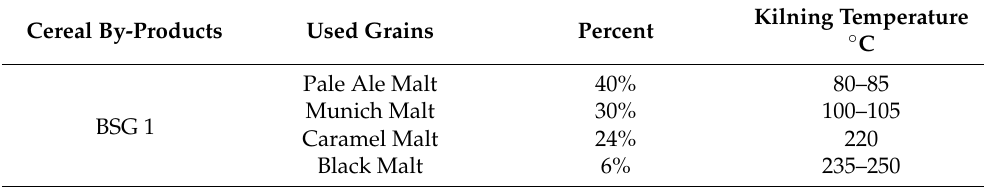
Table 1. Types and codification of the selected brewers’ spent grain samples. Cereal